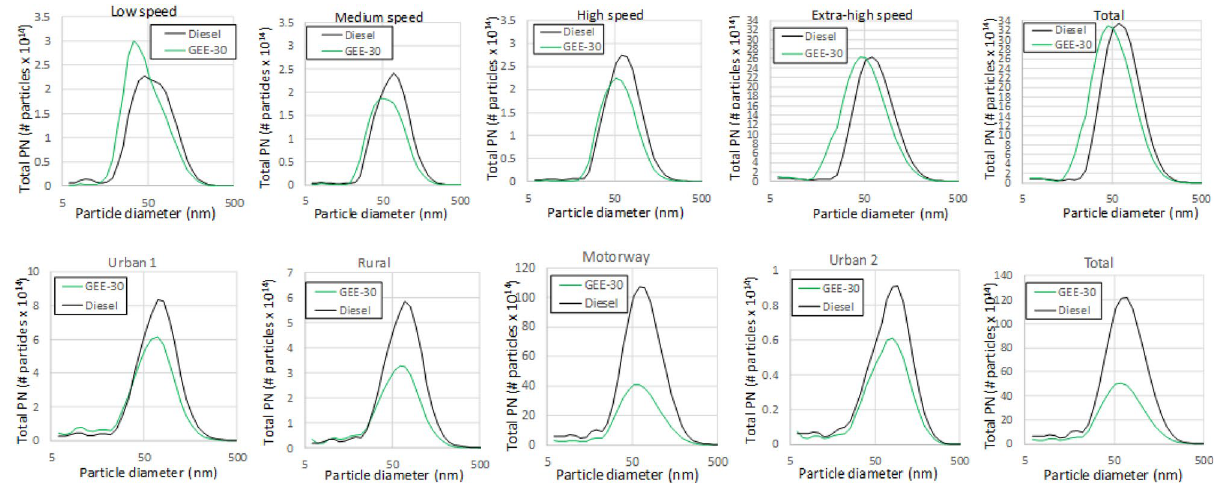
Figure 11. Average particle size distributions along WLTC (above) and along RDE